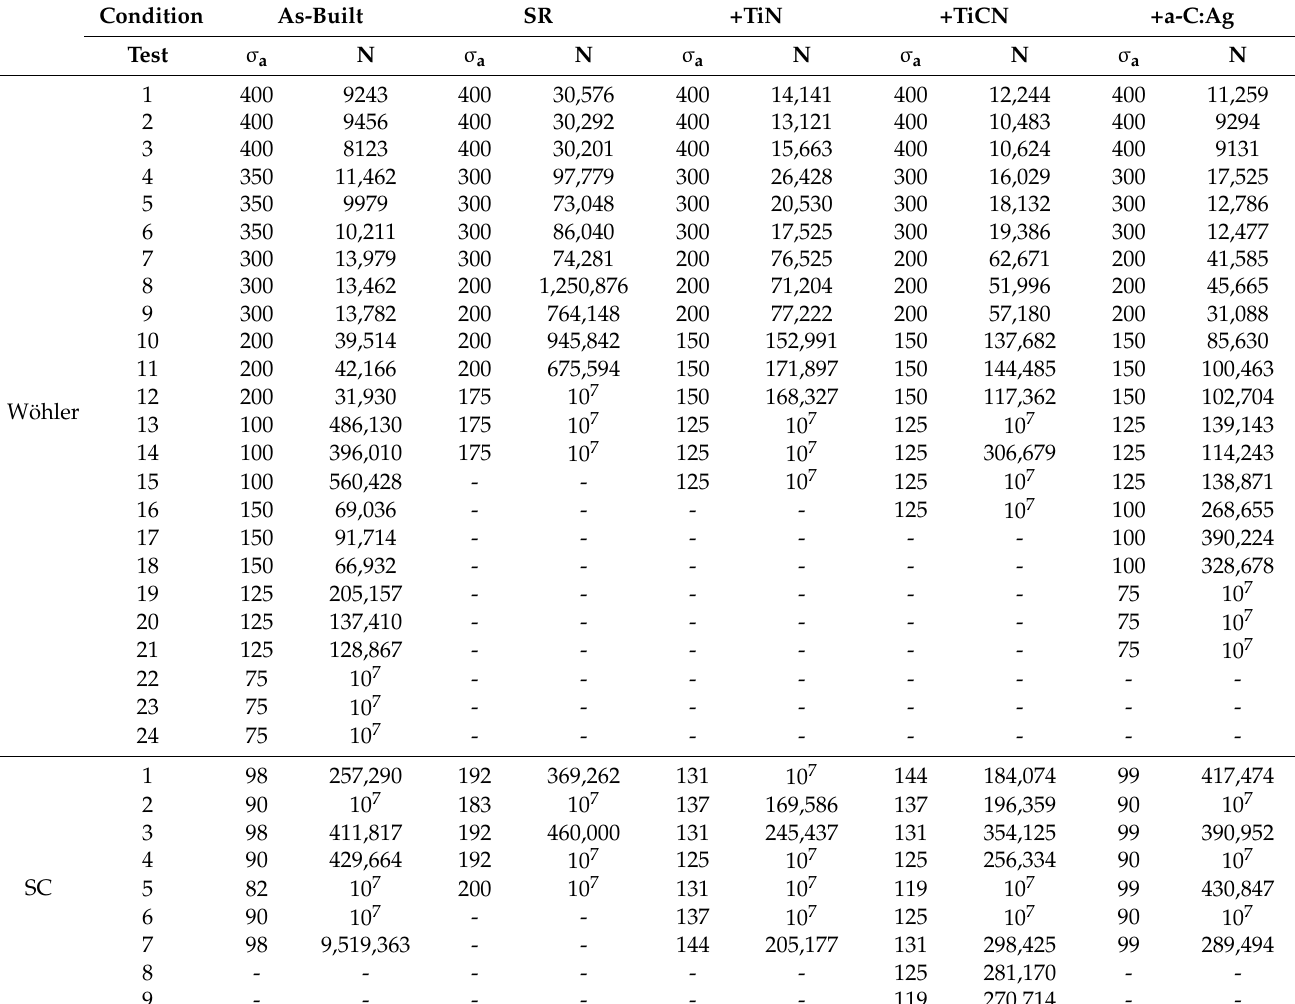
Table 2. Overview of the fatigue test results of the as-built, SR, TiN-coated, TiCN-coated, and a-C:Ag- coated conditions, with different stress amplitudes, σ a , and cycles to failure, N, for different test procedures, Wöhler curve and staircase test procedure (SC), 10 7 = run-outs.